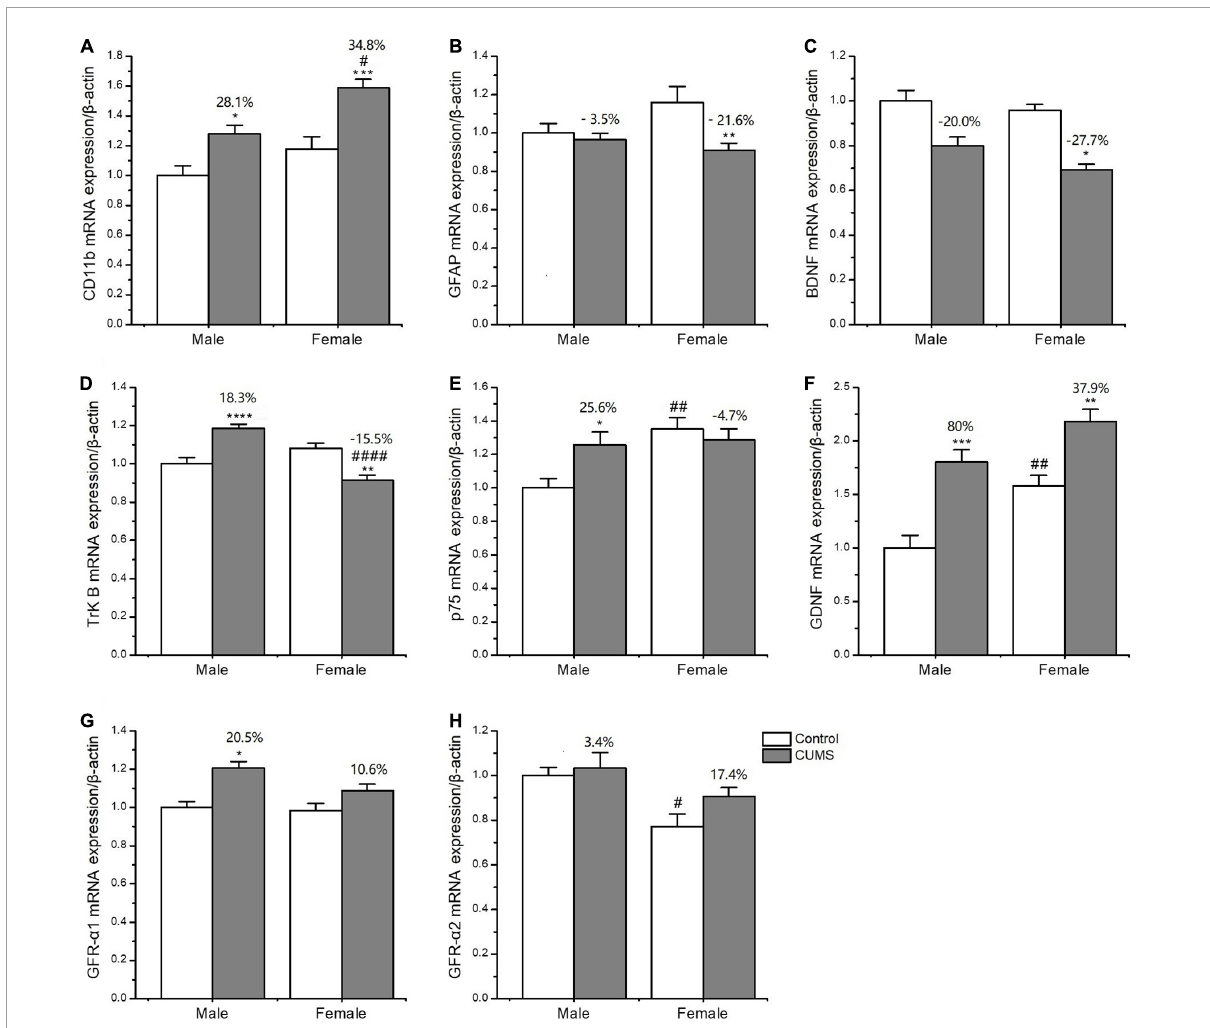
FIGURE10 CUMS influenced the mRNA expression of microglial and astroglial marker genes in the hippocampus of male and female rats. (A–H) qPCR analysis of microglial and astroglial marker genes of CD11b, glial fibrillary acidic protein (GFAP), brain-derived neurotrophic factor (BDNF), tyrosine kinase B receptor (TrkB), p75, GDNF, GFR- α 1, and GFR- α 2. * p < 0.05, ** p < 0.01, *** p < 0.001, and **** p < 0.0001 vs. control with same sex, # p < 0.05, ## p < 0.01, #### p < 0.0001 vs. male in same control or CUMS